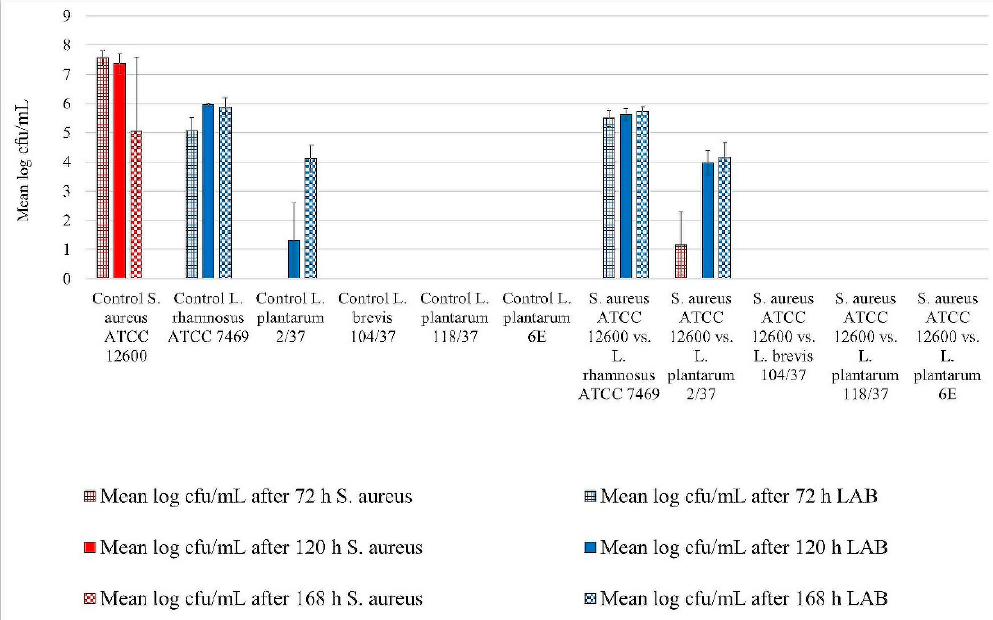
Figure 2. Biofilm challenge: S. xylosus (35/07) vs. LAB. Cfu/mL values are shown transformed by log (± standard error of the mean).